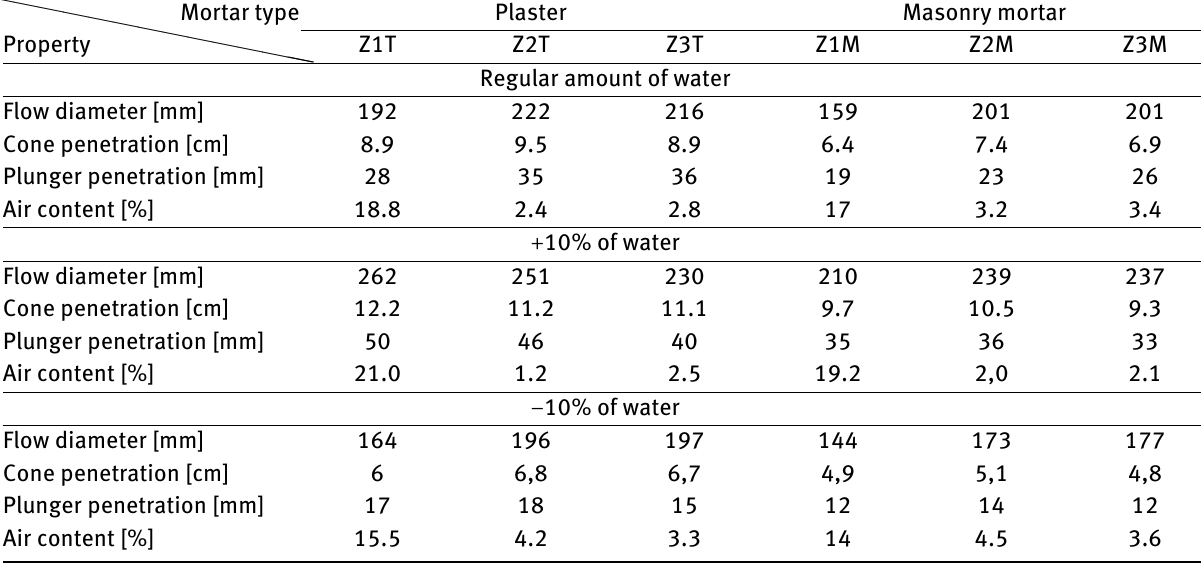
Table 5: Results of the tests of plaster and mortars with 10% fluctuations of water content. (cid:96)(cid:96)(cid:96)(cid:96)(cid:96)(cid:96)(cid:96)(cid:96)(cid:96)(cid:96)(cid:96)(cid:96)(cid:96)(cid:96)